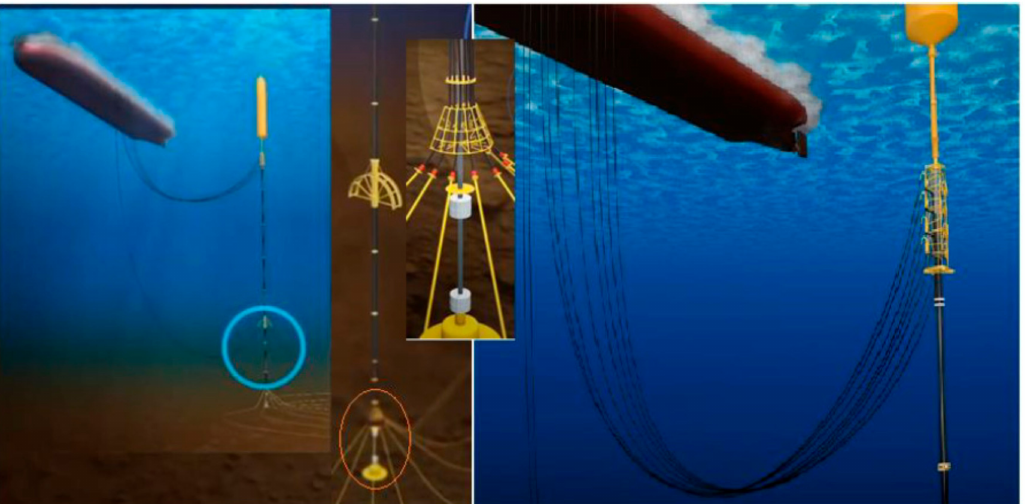
Figure 3. CompRiser as cost-saving composite riser with m-pipe’s decoupled solution, which is lightweight, with 7000 tons less of load per FPSO (considering 2 towers) in a collaboration between Magma Global and OCYAN. (Reproduced with permission obtained from Magma Global to reuse image of m-pipe